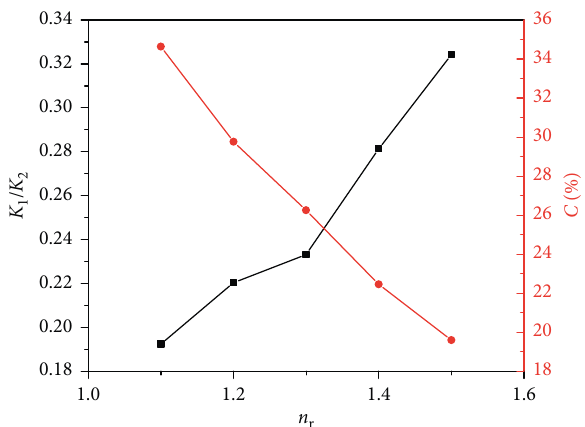
Figure 5: Relationship between stiffness ratio and energy ab- sorption coefficient with different diameter ratios.